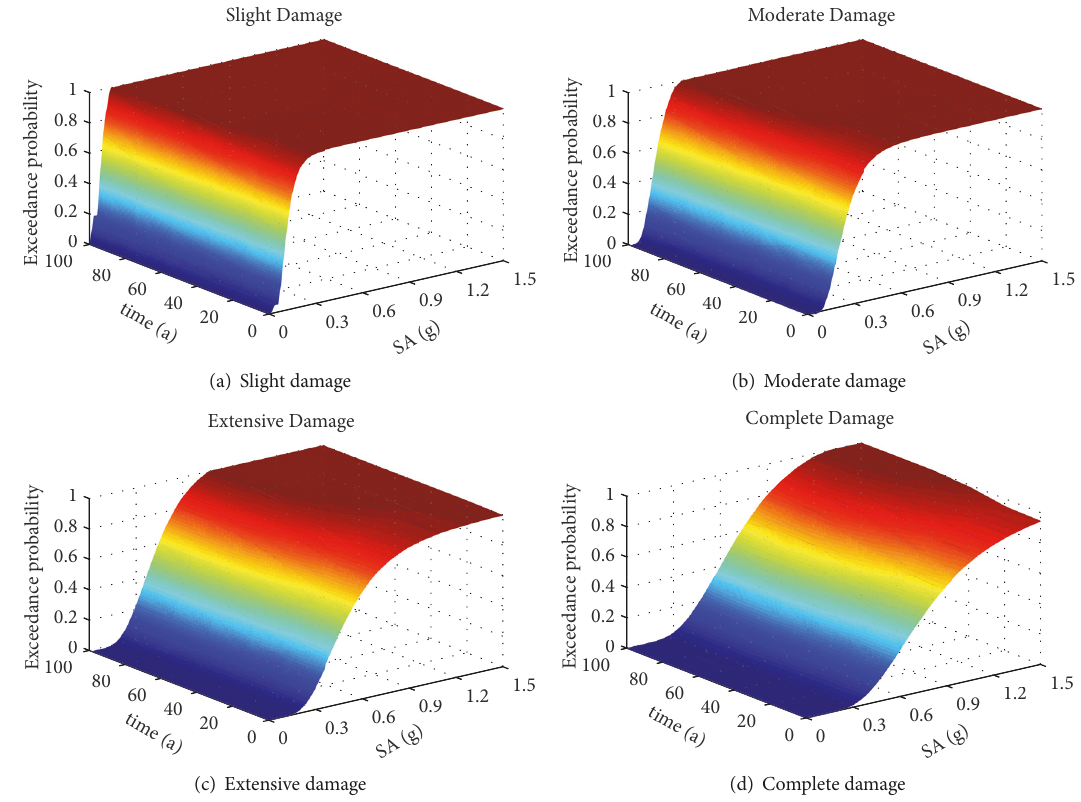
Figure 21: The vulnerability surfaces of left bridge platform under different damage states.